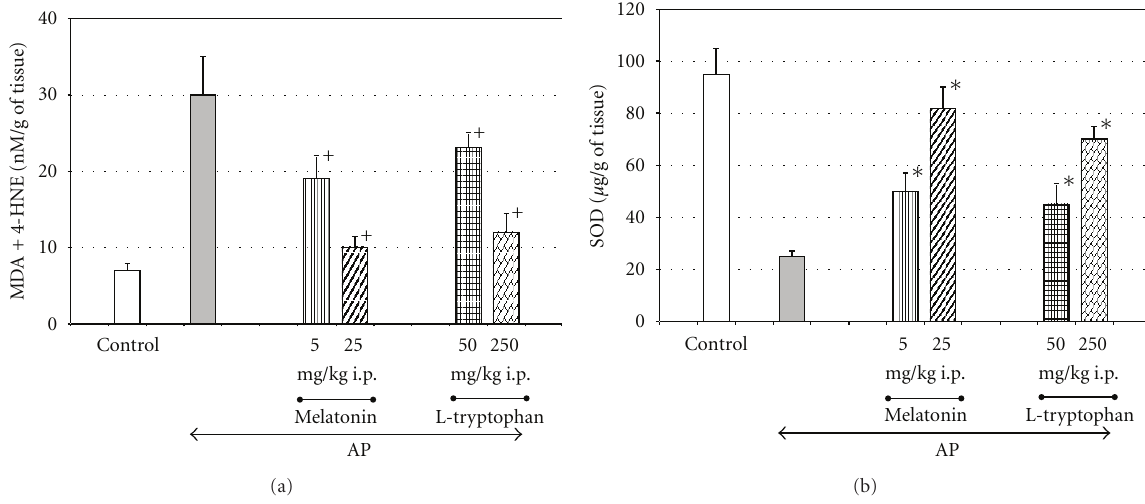
Figure 2: E ff ect of intraperitoneal (i.p.) application of melatonin or its precursor, L-tryptophan, on concentrations of antioxidative enzyme superoxide dismutase (SOD) and lipid peroxidation products (MDA + 4-HNE) in the pancreatic tissue taken from rats with acute pancreatitis (AP). Melatonin or its precursor, L-tryptophan, was applied as explained on Figure 1. Control—intact rats. Means ± SEM from the separate experiments, each performed on 8–10 rats. Asterisk indicates significant increase above the value detected in AP rats alone. Cross indicates significant decreases below the value detected in AP rats alone.